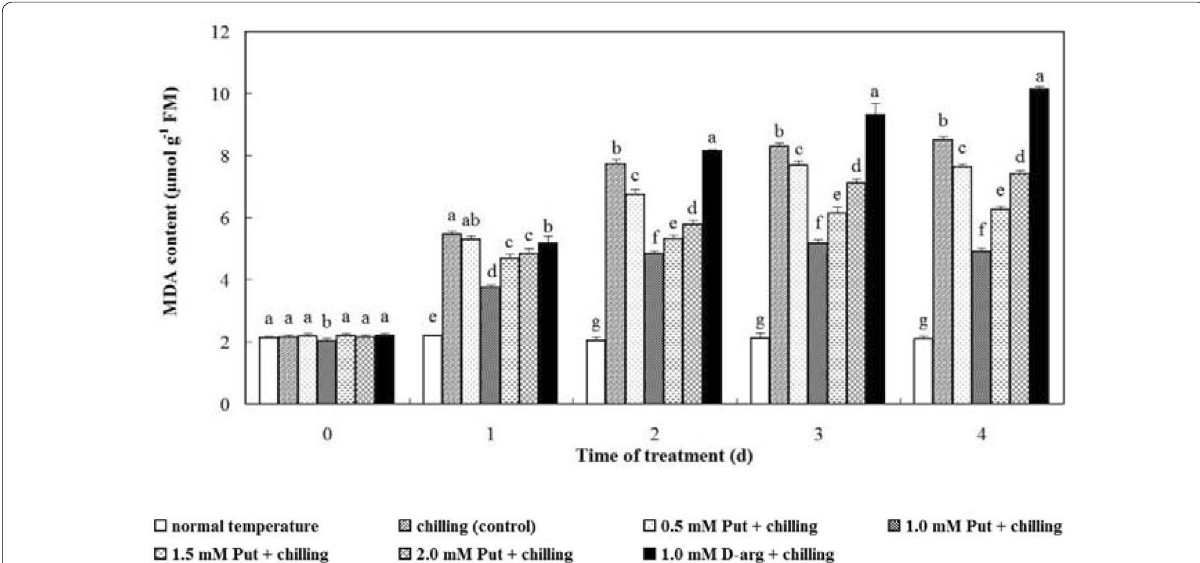
Fig. 2 Effects of exogenous Put and d -arg on MDA content in the leaves of anthurium seedlings under chilling stress. Seedlings were treated with normal temperature, chilling (control), 0.5 mM Put d -arg + chilling for 3 days and a recovery for 1 day, and the MDA content in the leaves was assayed. Each point represents the mean ± SE (n = 5). Treatments marked with different letters at a given sampling date are significantly different at P <